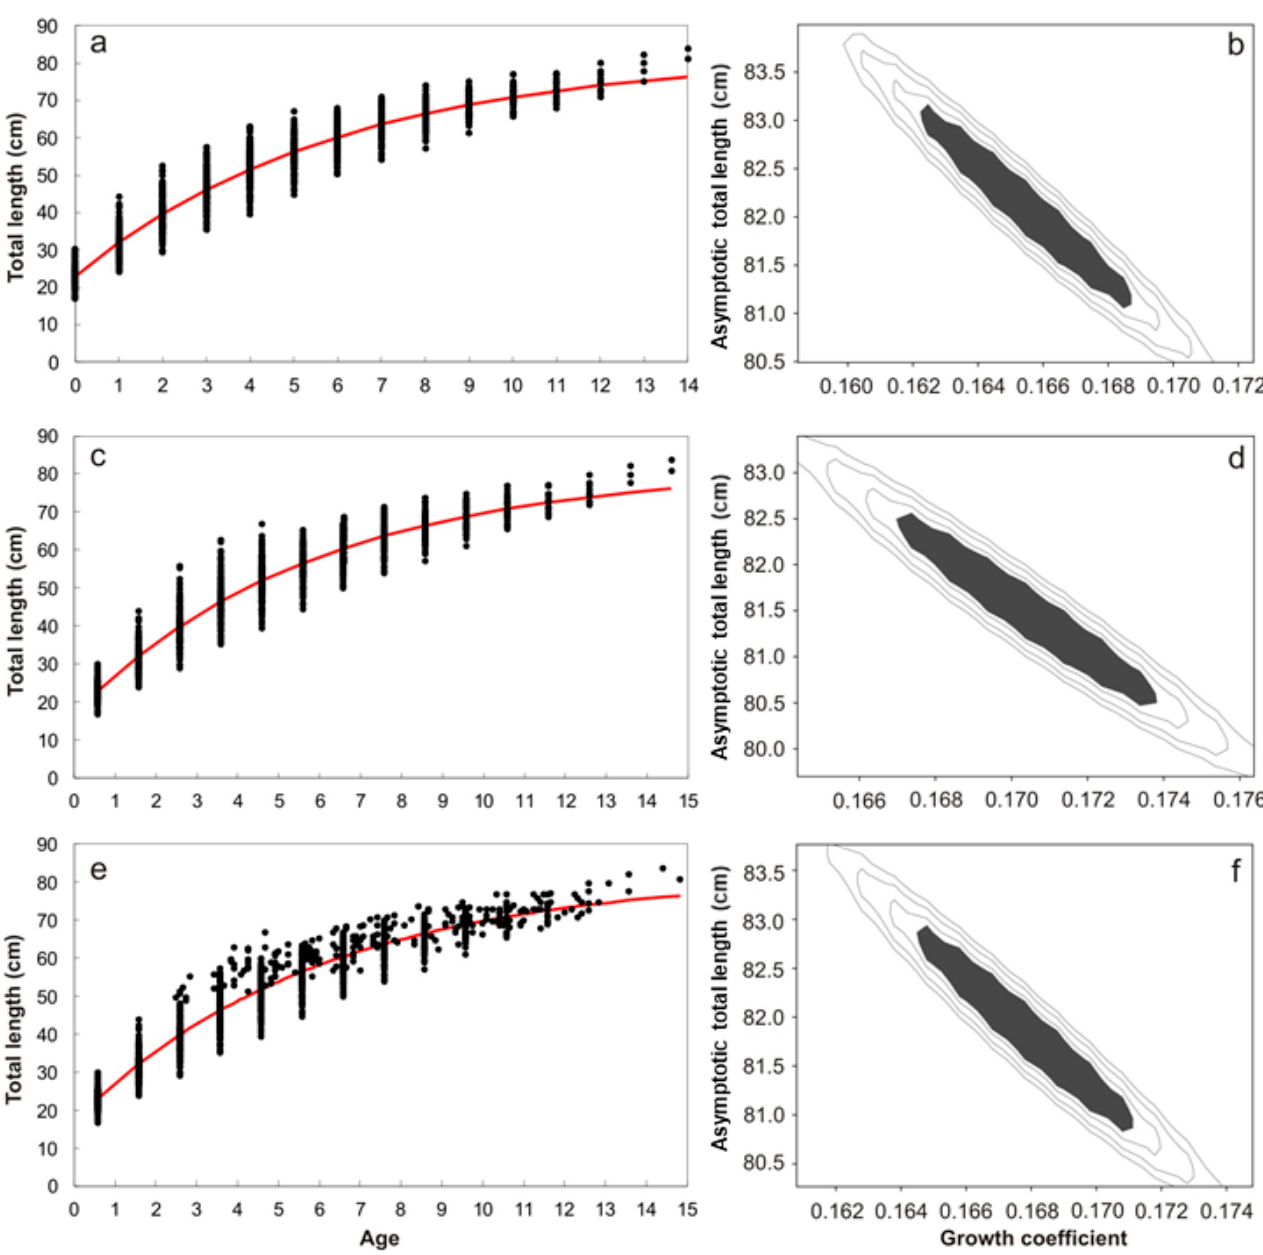
Figure 5. Growth curves and likelihood contours for L ∞ (asymptotic total length) and k (growth coefficient), estimated for VBG-3 for three different data sets: unadjusted ( a , b ), adjusted to reproductive cycle ( c , d ) and adjusted to reproductive cycle and date of capture ( e , f ). For growth curves, black dots represent the observed and back-calculated data, and the red lines represent estimated growth. For likelihood contours, shaded areas denote the confidence region for L ∞ and k , assuming a chi-square distribution with n = 2 df.